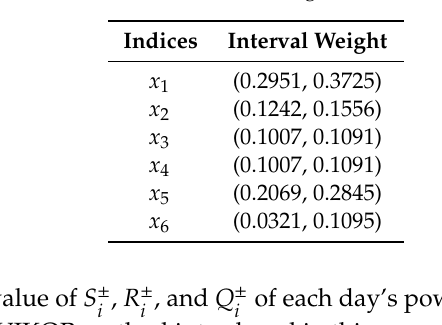
Table 11. The values of the S ±